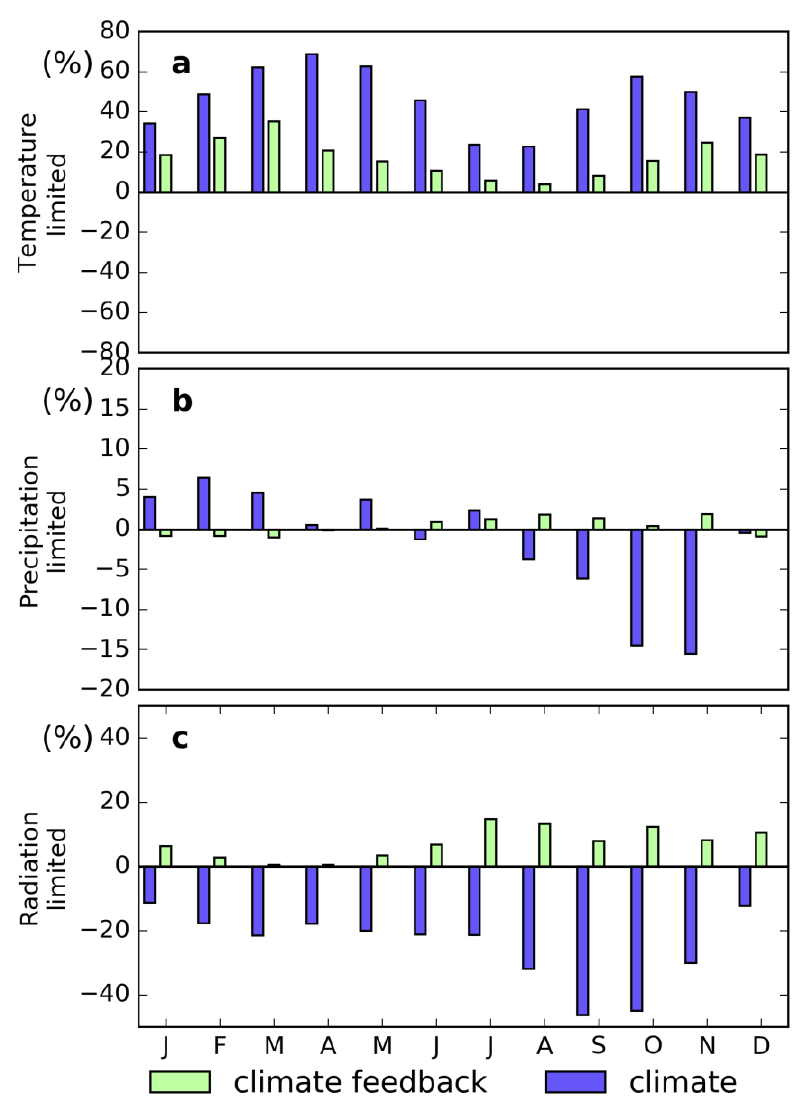
Figure 11. Monthly contribution of climate feedback and radiative climate change to vegetation growth in increases in CO 2 by 1%/year to 4xCO 2 experiment (1pctCO2) for each climate-limited area. The monthly contribution was calculated for each climate-limited region. The green and purple bars show the contribution of climate feedback and radiative climate change, respectively. In each region, the total of the contribution (CO 2 fertilization, climate feedback, and radiative climate change) was summed up to 100%.